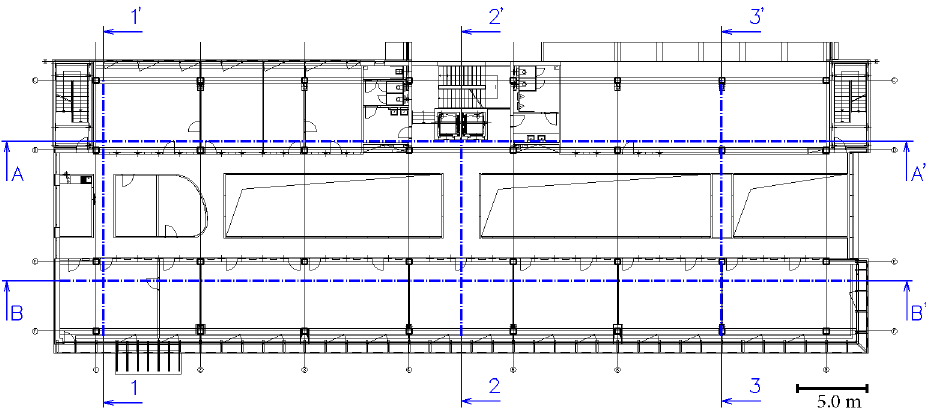
Figure 9. Positional layout of longitudinal and vertical cross sections of the 2 nd AGL